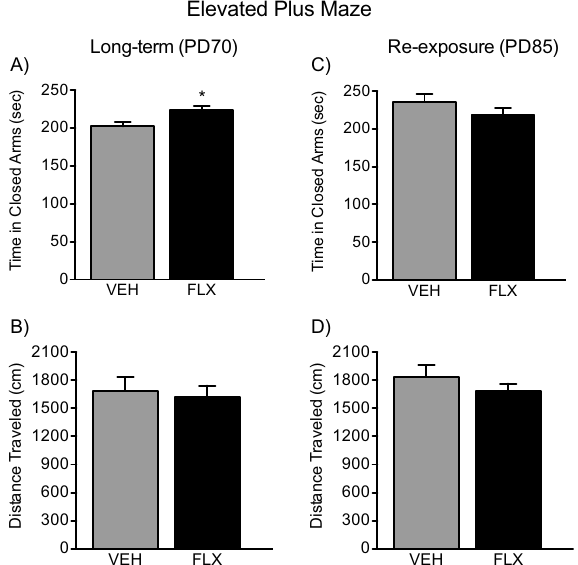
Figure 4. Long-term effects of juvenile fluoxetine (FLX) treatment, and its re-exposure in adulthood, on the elevated plus maze. ( A ) Adolescent FLX pretreatment (PD35-49) resulted in a significant increase in time spent in the closed arms of the maze at PD70 (Long-Term), when compared to water (VEH)-treated controls. ( B ) No differences in distance traveled during the 5-min test were observed between the groups. ( C ) Re-exposure of FLX in adulthood (PD70-84) ameliorated the long-lasting anxiety-like effect of juvenile FLX pre-exposure since no differences in total time spent in the closed arms were noted between the groups (PD85). ( D ) No differences in distance traveled were observed between the experimental groups. Data are presented as mean ± SEM. * p <